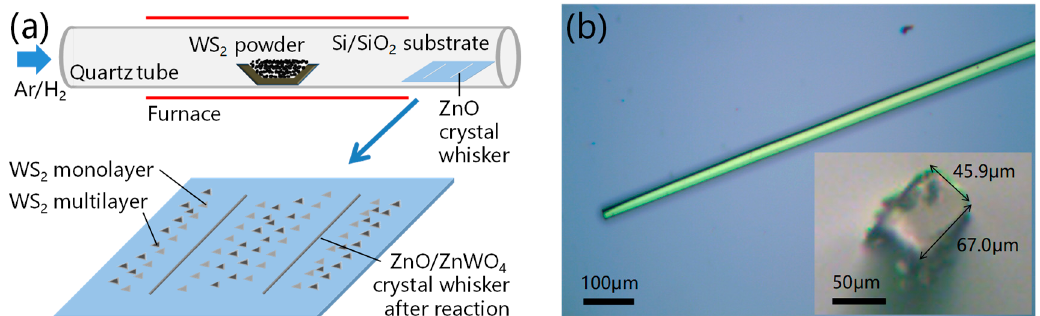
Figure 1. ( a ) Schematic diagram of the home-built chemical vapor deposition (CVD) system and tungsten disulfide (WS 2 ) after CVD growth. ( b ) Optical microscopy image of ZnO crystal whisker transferred onto the surface of SiO 2 /Si substrate before WS 2 growth. Insert illustration: cross section of ZnO crystal whisker with a length and width of 67.0 μ m and 45.9 μ m, respectively.